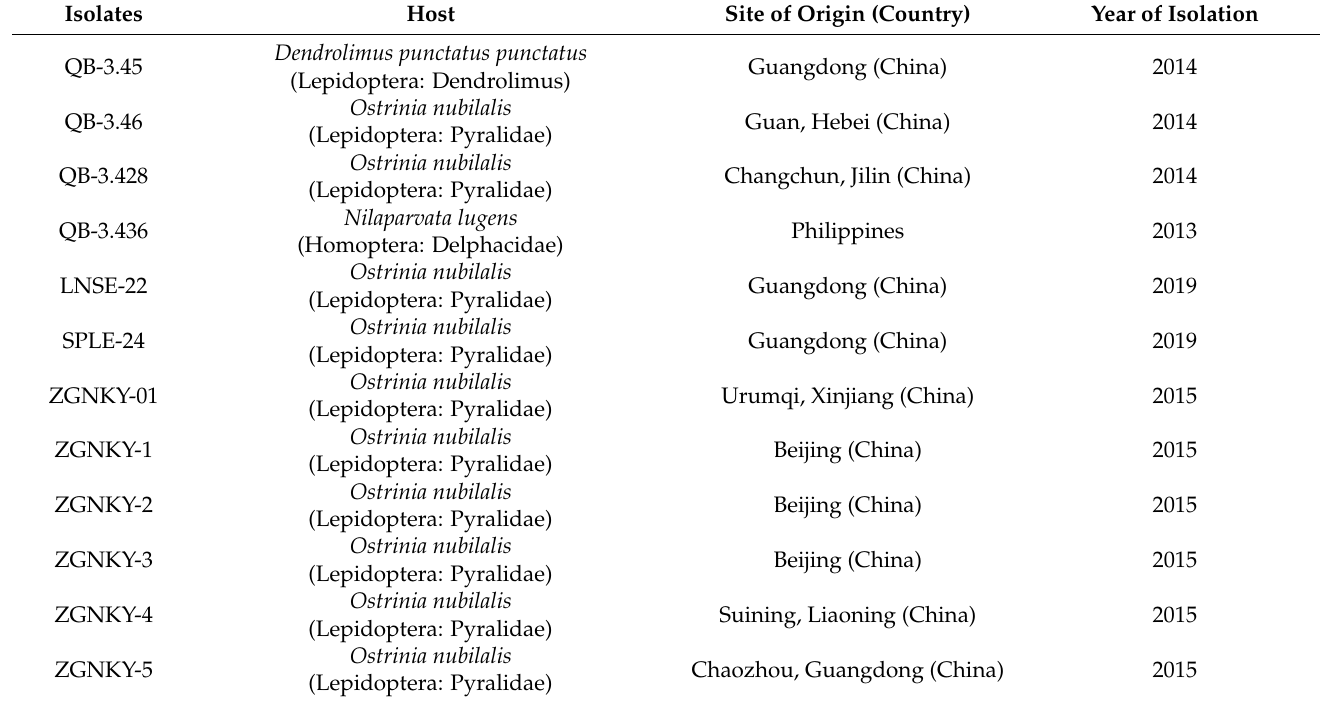
Table 1. Information about the isolates of B. bassiana tested against FAW in this